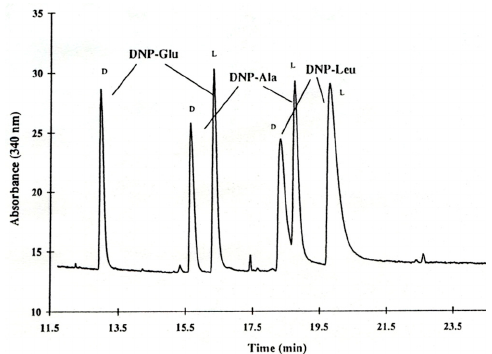
Figure 8. Enantioseparation of D , L -DNP-amino acids in a running electrolyte containing cyclo (Arg- Lys-Tyr-Pro-Tyr- β -Ala) (10 mM in 20 mM sodium phosphate buffer, pH 7.0) as chiral mobile phase additive (CMPA) in CE. Column: 57 cm (effective) × 50 μ m I.D.; − 20 kV, 15 °C. Reprinted